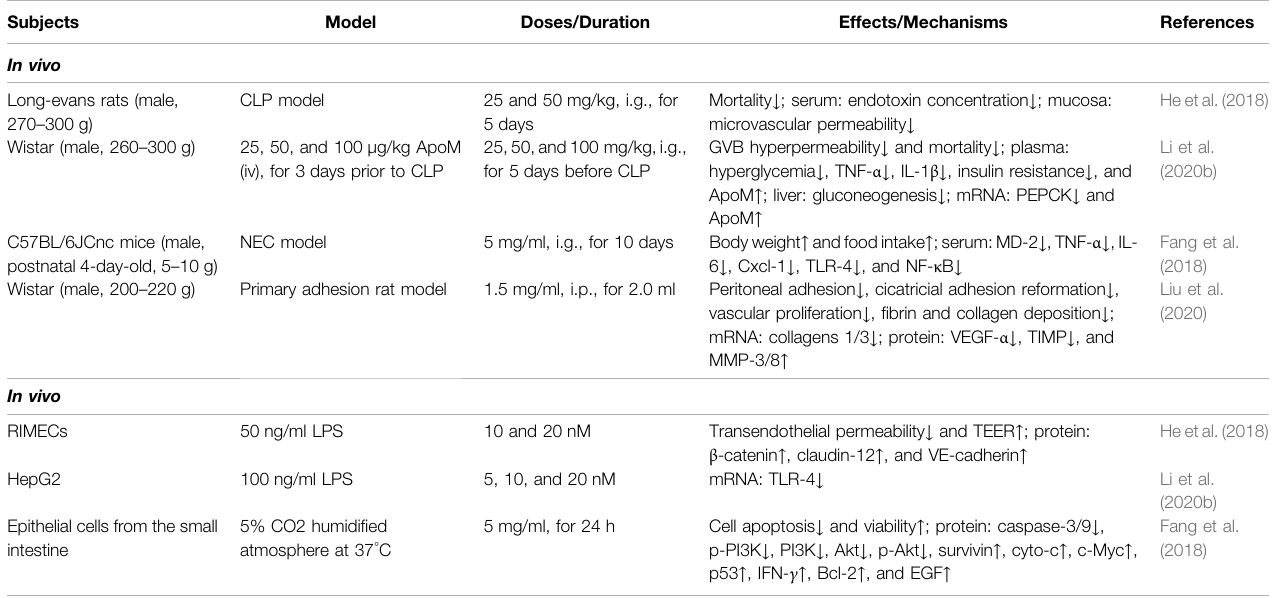
TABLE 6 | The in vivo and in vitro mechanism of berberine in the treatment of intestinal vascular